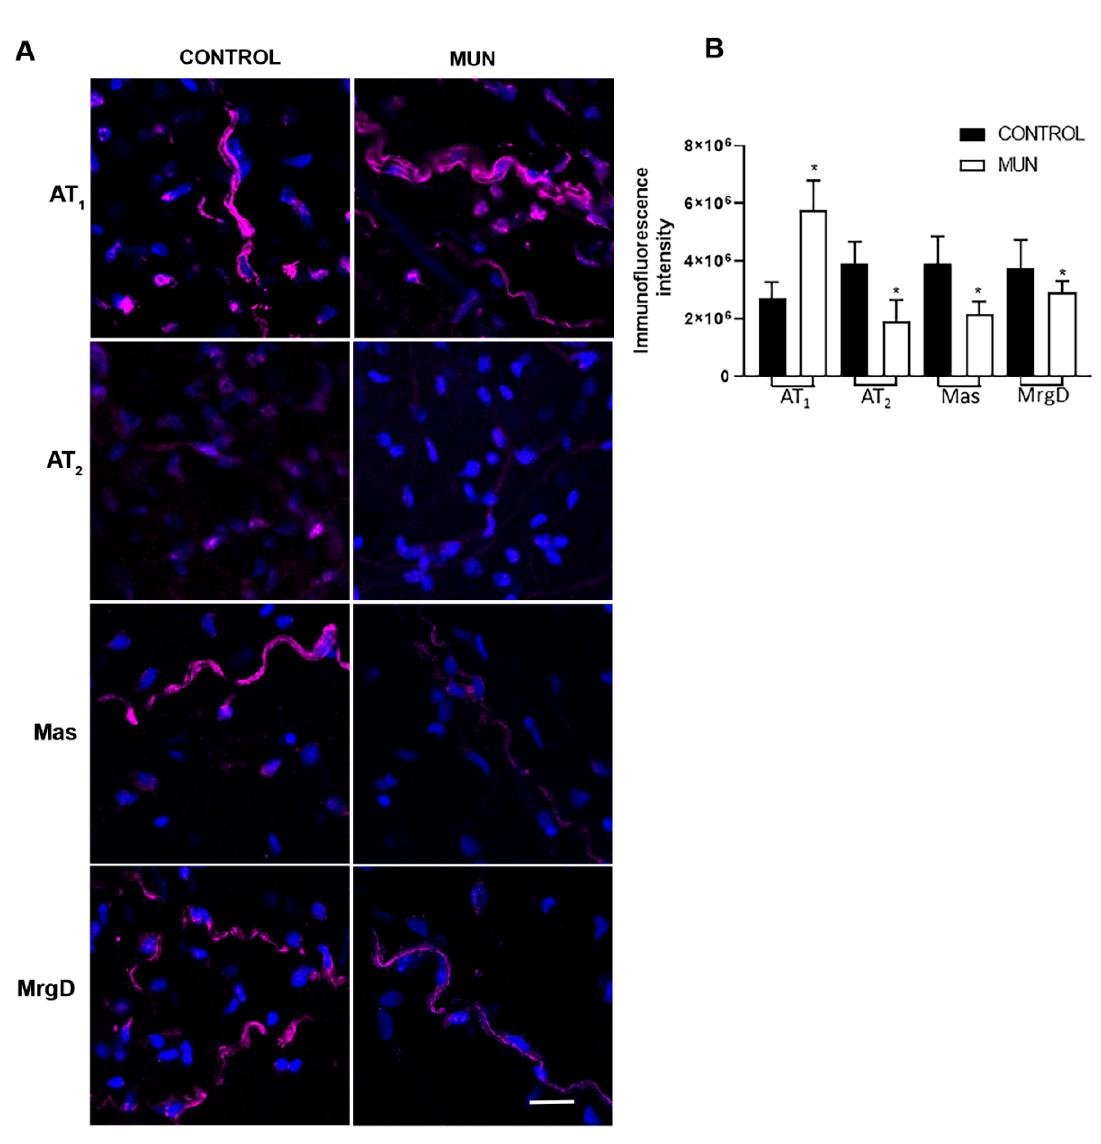
Figure 3. Impact of fetal undernutrition on the distribution profile of RAS receptors in the adventitia layer of mesenteric arteries in 6 -month-old male offspring from rats exposed to maternal undernu- trition during pregnancy (MUN) and rats fed ad libitum (CONTROL). ( A ) Laser scanning confocal microscopy representative images of CONTROL and MUN mesenteric arteries exhibiting AT 1 , AT 2 , Mas or MrgD receptors (red) and nuclei (blue); ( B ) and quantitative analysis of LSCM images. Values are expressed as mean ± s.e.m. from 6 rats in each group. Significant differences from CONTROL rats: * p < 0.05.